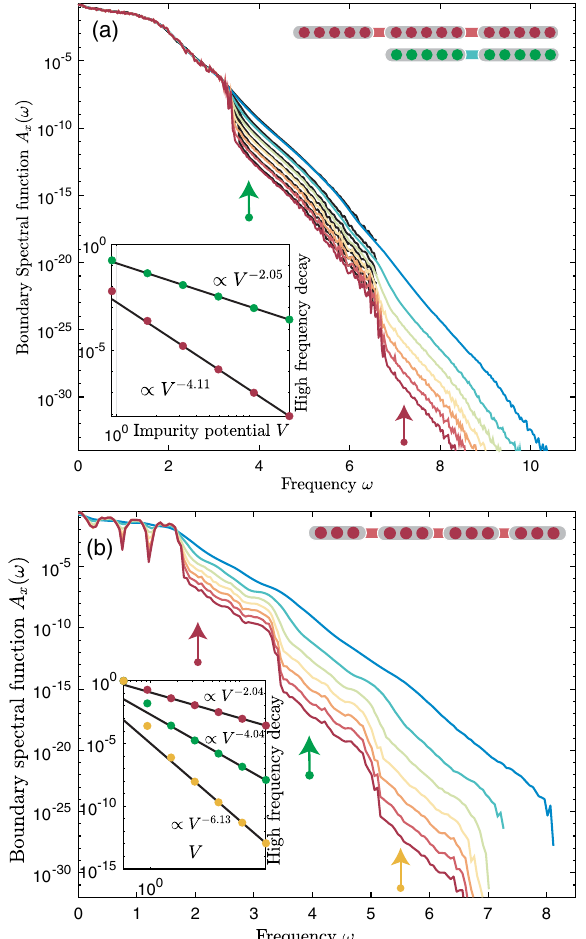
FIG. 3. Boundary spectrum II: the high-frequency part of the spectral function of the S x operator on the boundary of a chain with a weak link J eff l ¼ 1 = ð 2 V l Þ after every fifth site (a) and every third site (b); color goes from blue to red with increasing V . The black dashed lines in (a) are for a system of L ¼ 10 , indicating that the intermediate frequency part remains un- changed with increasing system size. The insets show the scaling of the jumps in the spectral function at the frequencies indicated by the corresponding arrows in the main